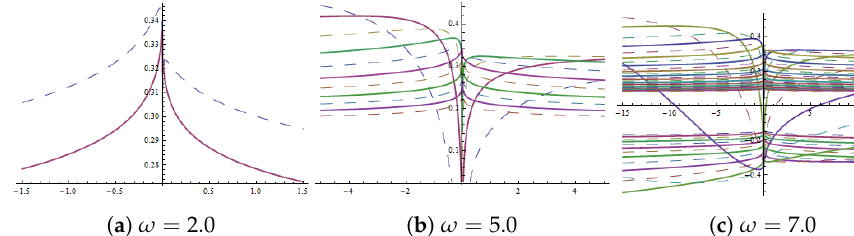
Figure 2. ( a – c ) show three-dimensional plots.